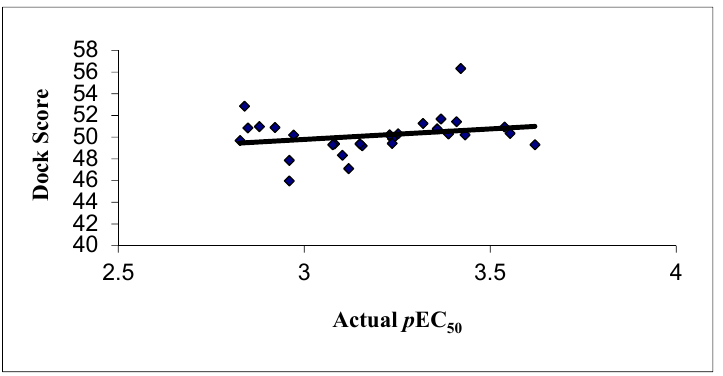
Figure 5. Correlation between the experimental activities and dock score in GOLD docking.